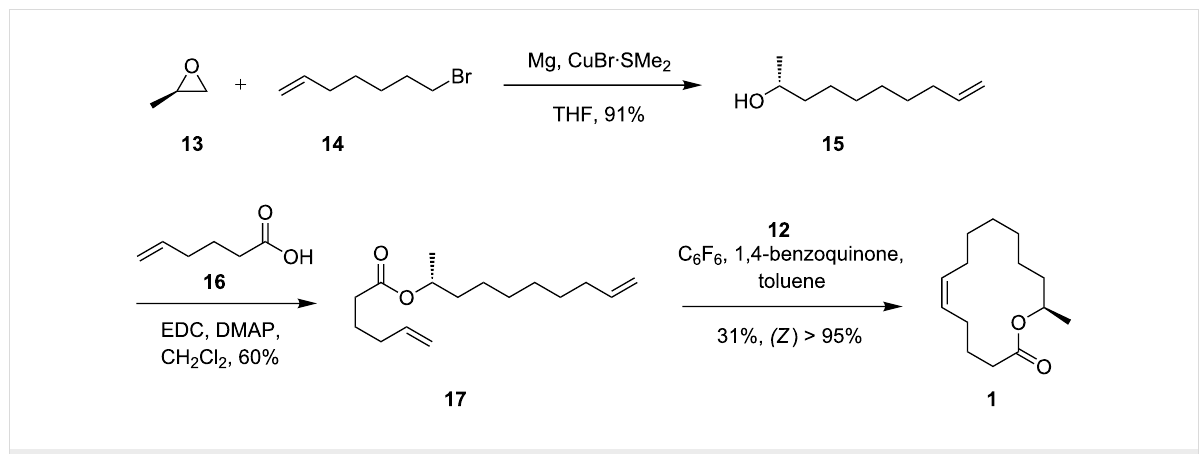
Scheme 2: Synthesis of (5 Z ,13 R )-tetradec-5-en-13-olide (( R )- 1 ). The enantiomer was obtained in a similar sequence, starting from ( S )-propylene oxide instead of 13 .